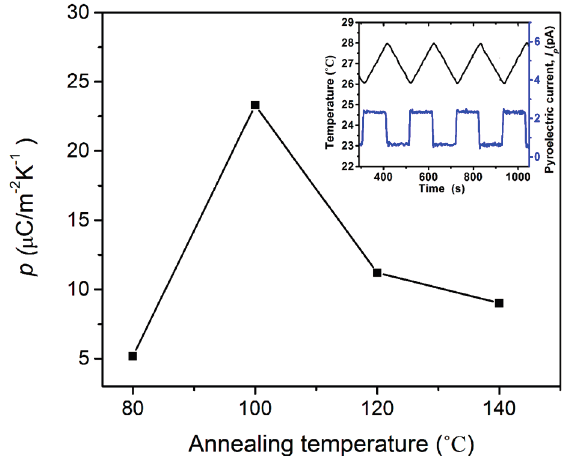
Figure 9. Pyroelectric coefficient, p , of P(VDF-TrFE) thin films with varying annealing temperature